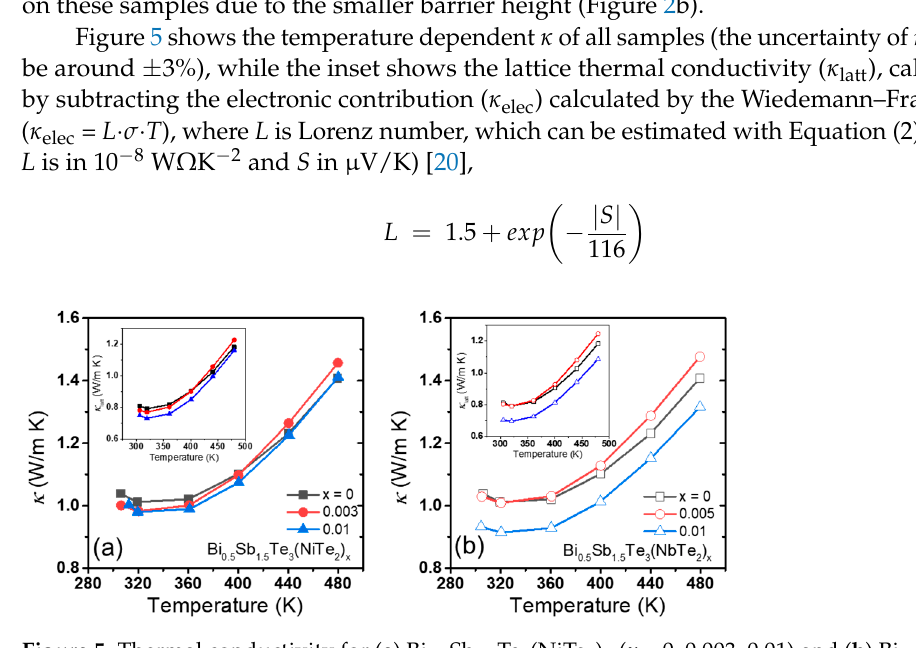
Figure 5. Thermal conductivity for ( a ) Bi 0.5 Sb 1.5 Te 3 (NiTe 2 ) x ( x = 0, 0.003, 0.01) and ( b ) Bi 0.5 Sb 1.5 Te 3 (NbTe 2 ) x ( x = 0, 0.005, 0.01). Insets shows the lattice thermal conductivity ( κ latt ).